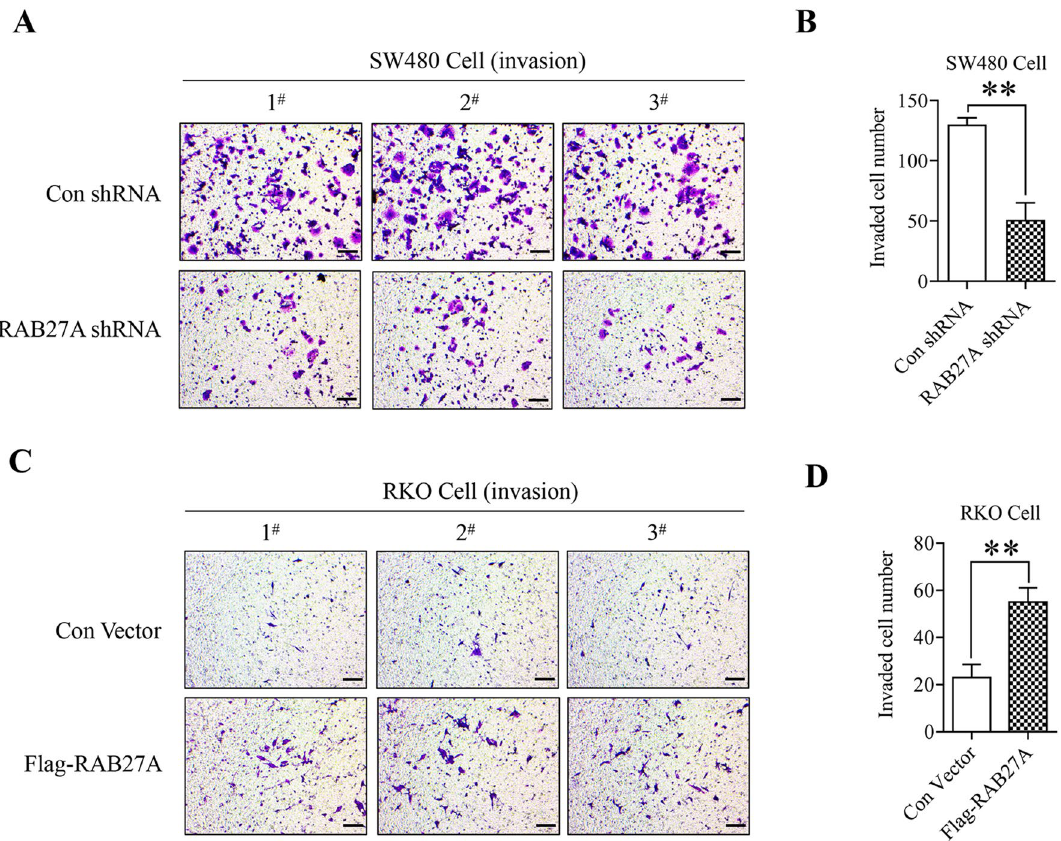
Figure 5. The effect of RAB27A on colon cancer cell invasion. ( A ) and ( B ). RAB27A knockdown suppresses SW480 cell invasion. RAB27A knockdown and the negative control SW480 cells were seeded in the upper well of the Transwell chamber pre-coated with Matrigel for 48 h, and the invaded cells were stained with the crystal violet. ( C ) and ( D ). RAB27A overexpression facilitates RKO cell invasion. RAB27A overexpression and the negative control RKO cells were seeded in the upper well of the Transwell chamber pre-coated with Matrigel for 48 h, and the invaded cells were stained with the crystal violet. Cell invasion was determined by microscopy (200 ×). At least three fields in each group were observed, and the representative images were shown (scale bar = 100 µm). Invaded cell number in each field was calculated, shown as mean ± S.D. and analyzed by two- tailed t-test. The value of the vertical axes in this figure is invaded cell number per field of view. ** P < 0.01. All the experiments were repeated three times independently and the representative results were